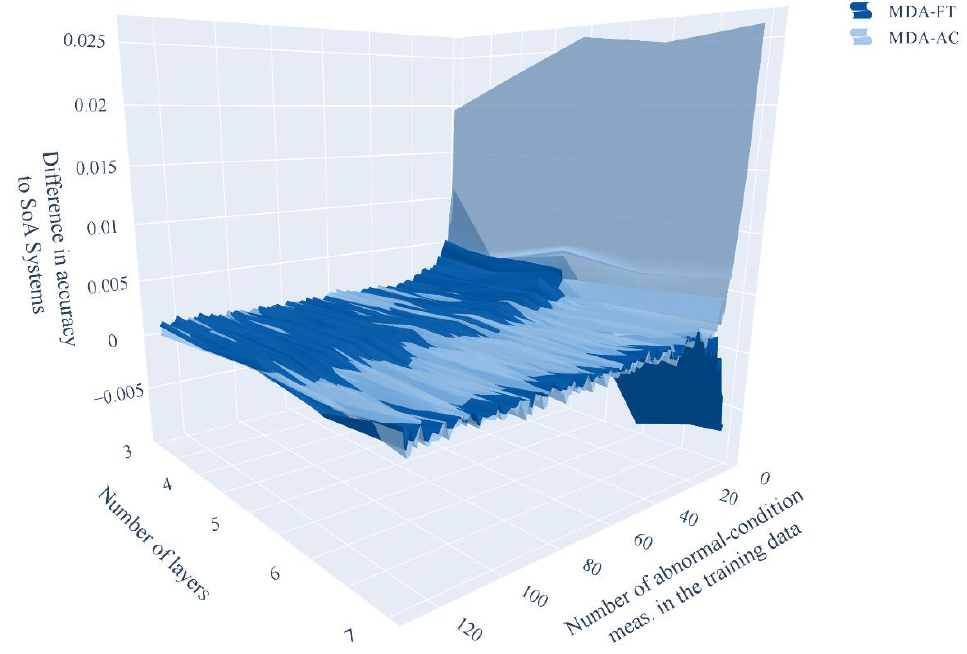
Figure 17. Differences in accuracy between the MDA-FT , MDA-AC, and the SoA Systems . Table 2. Averaged difference in accuracy between the MDA-FT , MDA-AC, and the SoA Systems . Averaged Accuracy Difference in %